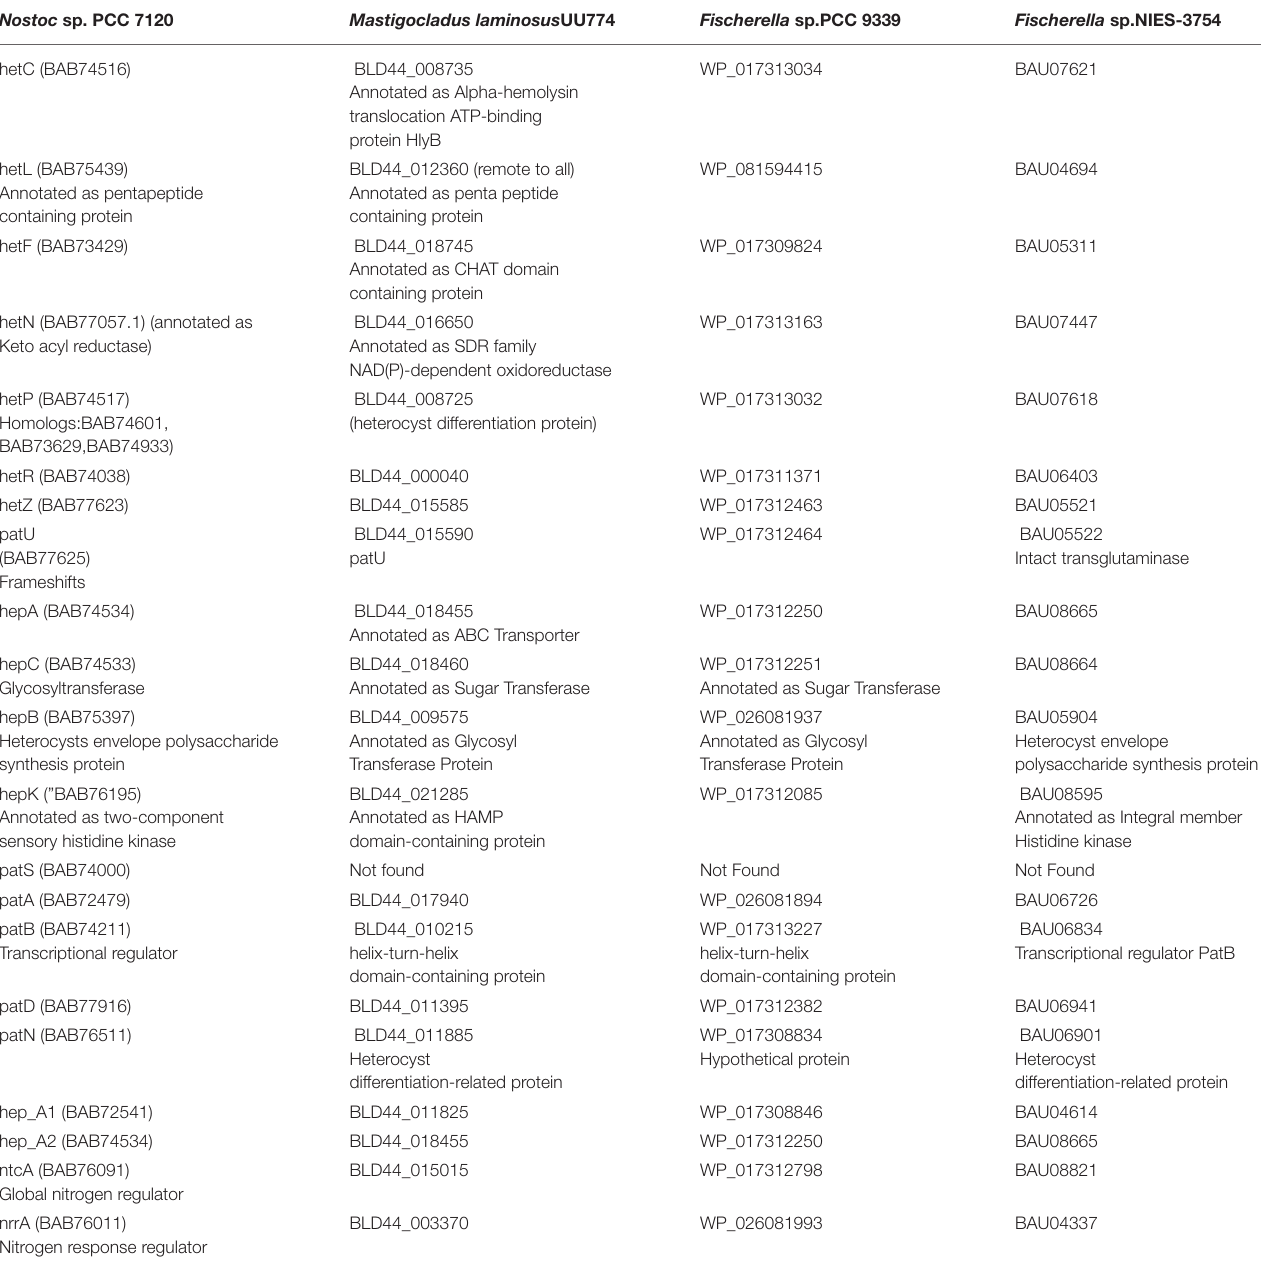
TABLE 2 | Curated genes involved in heterocyst biogenesis and function in UU774, PCC 9339, NIES-3754, and PCC 7120. Nostoc sp. PCC